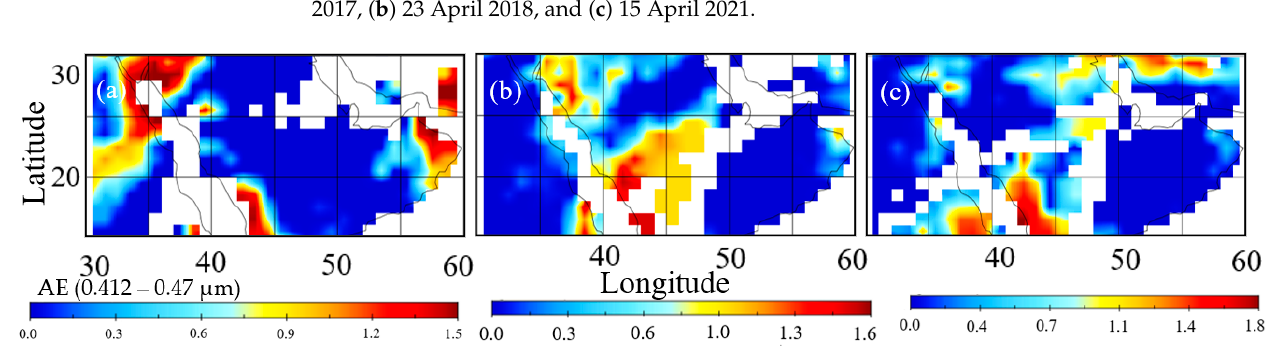
Figure 4. AE in the band 0.412–0.47 µm during some major dust storms blown over Saudi Arabia on ( a ) 20 March 2017, ( b ) 23 April 2018, and ( c ) 15 April 2021. ( a ) 20 March 2017, ( b ) 23 April 2018, and ( c ) 15 April